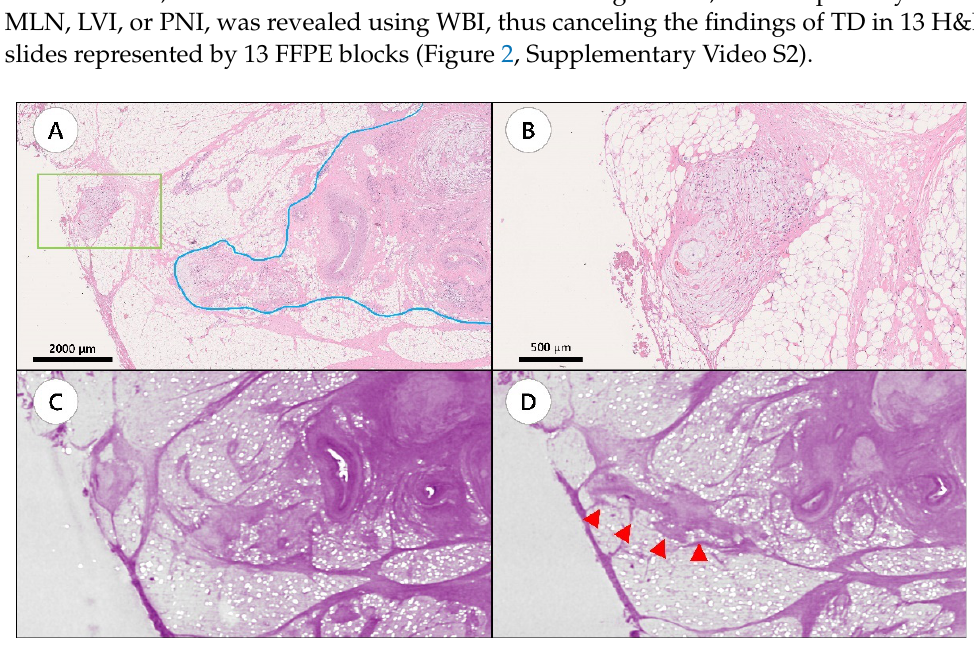
WSI, whole-slide imaging; WBI, whole-block imaging; BLN, benign lymph node; MLN, metastatic lymph node; NA, not assessed. † BLNs and MLNs were counted for all reviewed 237 H&E slides for WSI and 237 formalin-fixed paraffin-embedded blocks for WBI.